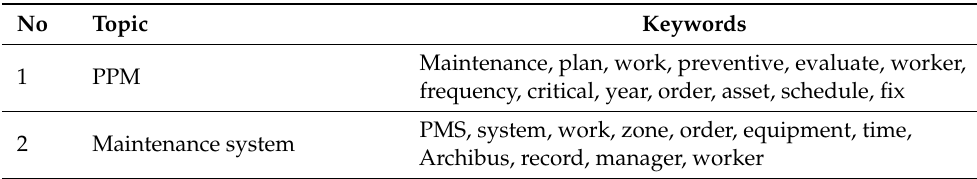
Table 4. Topics and keywords identified from the